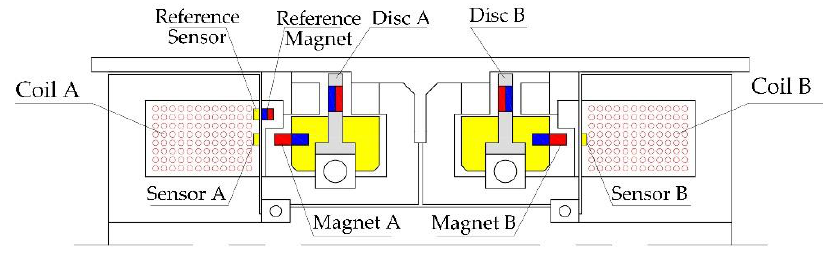
Figure 12. Installation position of Hall sensor and permanent magnets.